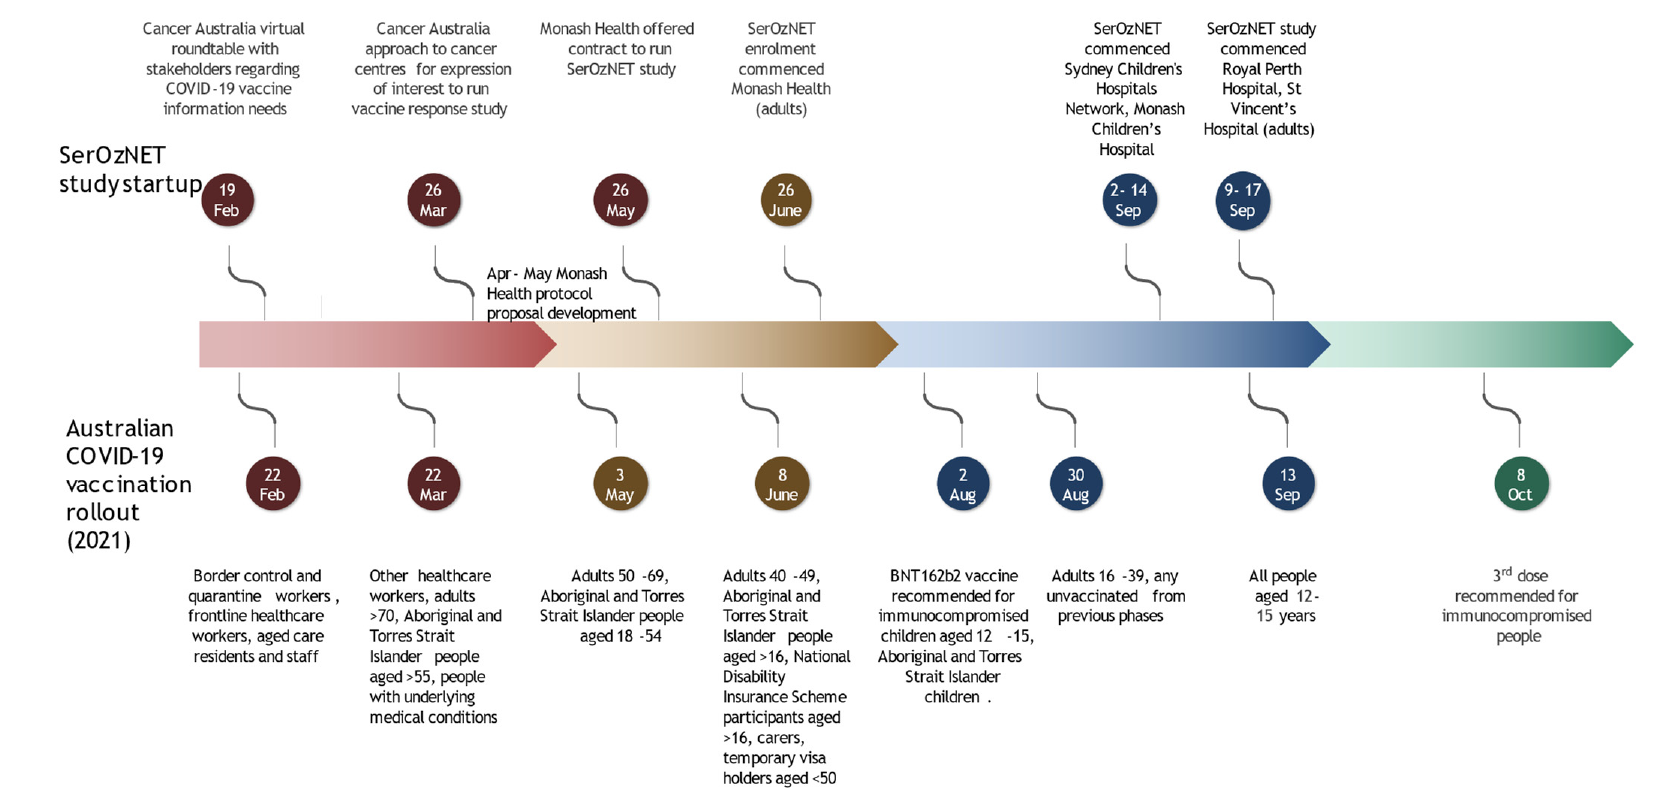
Figure 1. Timeline of Australian COVID ‐ 19 vaccine rollout and SerOzNET study startup [16–22].